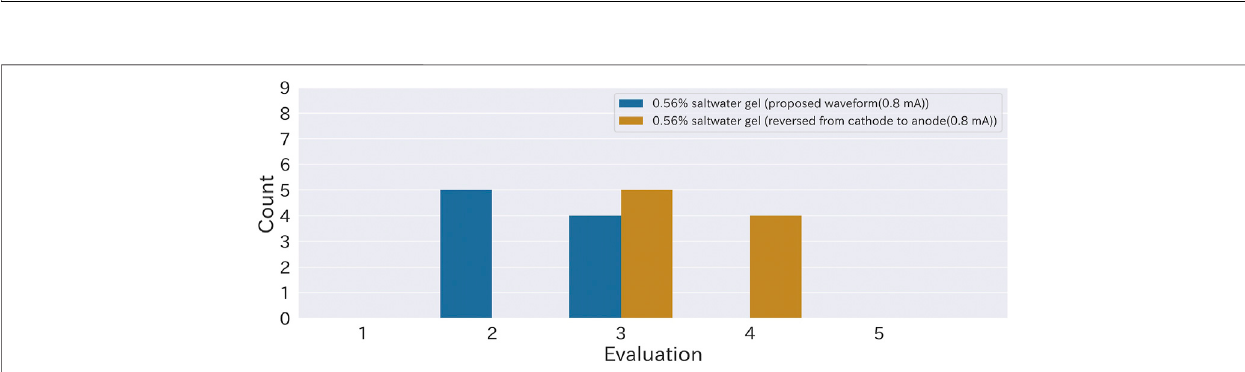
Frontiers in Virtual Reality |